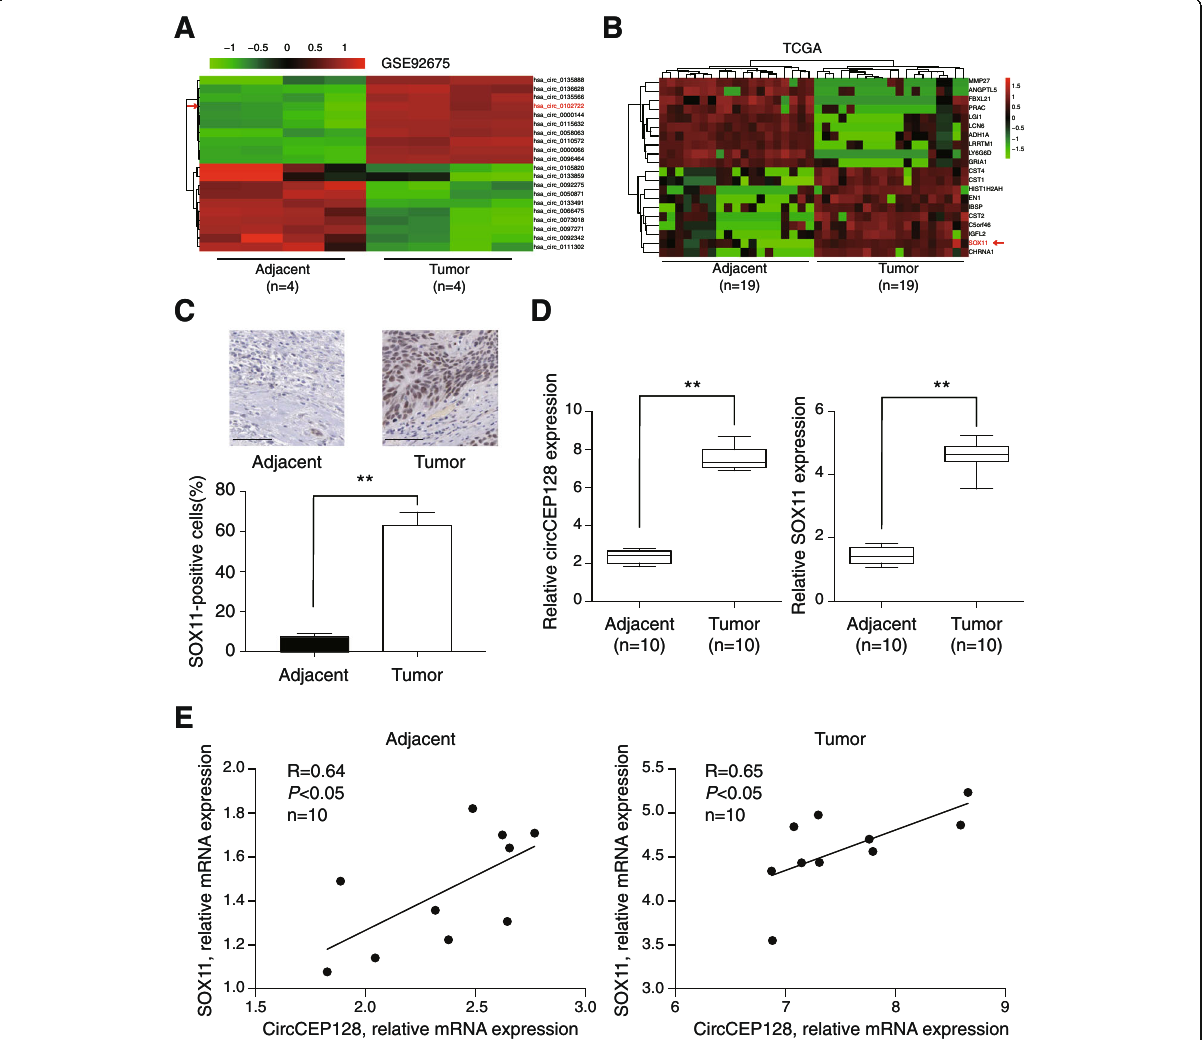
Fig. 1 CircCEP128 and SOX11 are up-regulated in bladder cancer. a The cluster heatmap showed some of the differentially expressed circRNAs over 2-fold change between tumor tissues and adjacent normal tissues. Red color indicates high expression level, and green color indicates low expression level. The red arrow indicates hsa_circ_0102722 (circCEP128). b The cluster heat map showed some of the differentially expressed mRNAs over 2-old change in tumor tissues and adjacent normal tissues. The red arrow indicates SOX11 . c Immunochemistry staining showed more SOX11 -positive cells in tumor tissues than in adjacent normal tissues. Scale bar, 50 μ m . ** P <0.01, compared with adjacent tissues. d CircCEP128 and SOX11 were highly expressed in tumor tissues. ** P <0.01, compared with adjacent tissues. e According to the results of qRT-PCR, circCEP128 and SOX11 were positively related in cancer tissues and in cancer adjacent